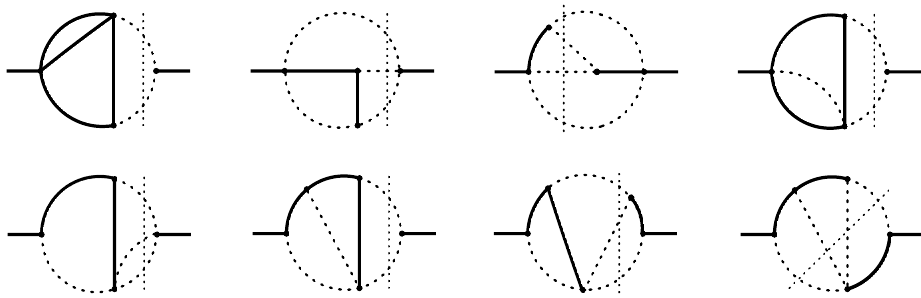
Figure 2 . Sample three-loop propagator-type integrals that parameterize large- z expansions of the MIs. Massless and massive internal propagators are denoted by dotted and solid lines, respectively. The thin dotted lines indicate the unitarity cuts.